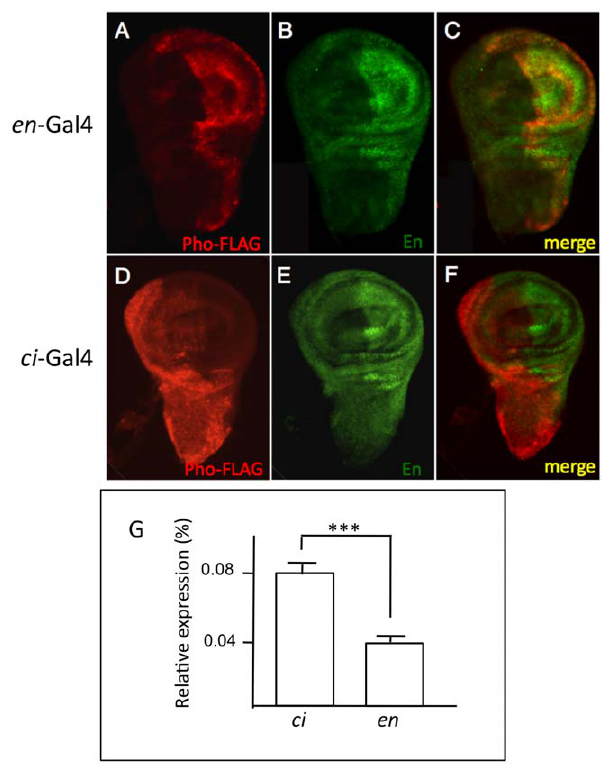
Figure 2. Stable expression of Pho-FLAG in cells that express En or Ci. UAS-Pho-FLAG expression by the en -GAL4 or ci -GAL4 driver. Anti-FLAG staining is red, anti-En staining is green. (A–C) 3 rd instar wing imaginal disc collected from a UAS-Pho-FLAG, en -GAL4 cross. Panel C shows nearly complete overlap of anti-FLAG and anti-En staining. (D–F) 3 rd instar wing imaginal disc collected from a UAS-Pho-FLAG, ci -GAL4 cross. Panel F shows complementary staining of anti-FLAG and anti-En. Note that the size of the anterior compartment, where Ci is expressed is about twice thesizeof theposterior compartment, where En is expressed [35]. (G) qRT-PCR showing that there is about twice as much Pho-FLAG transcript when it is driven by ci -Gal4 than by en -Gal4 (*** P # 0.001).